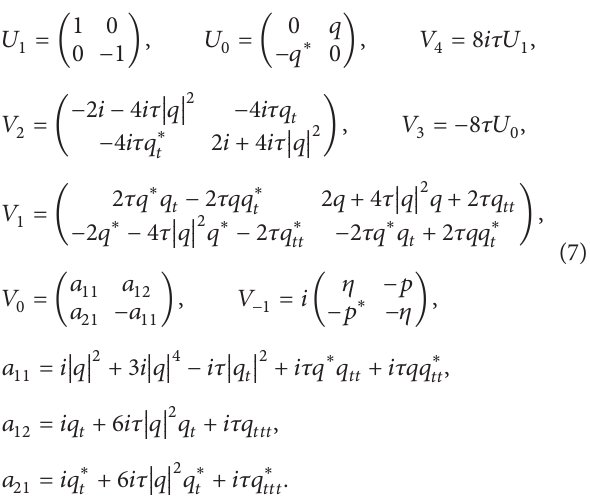
with 𝜆 as a spectral